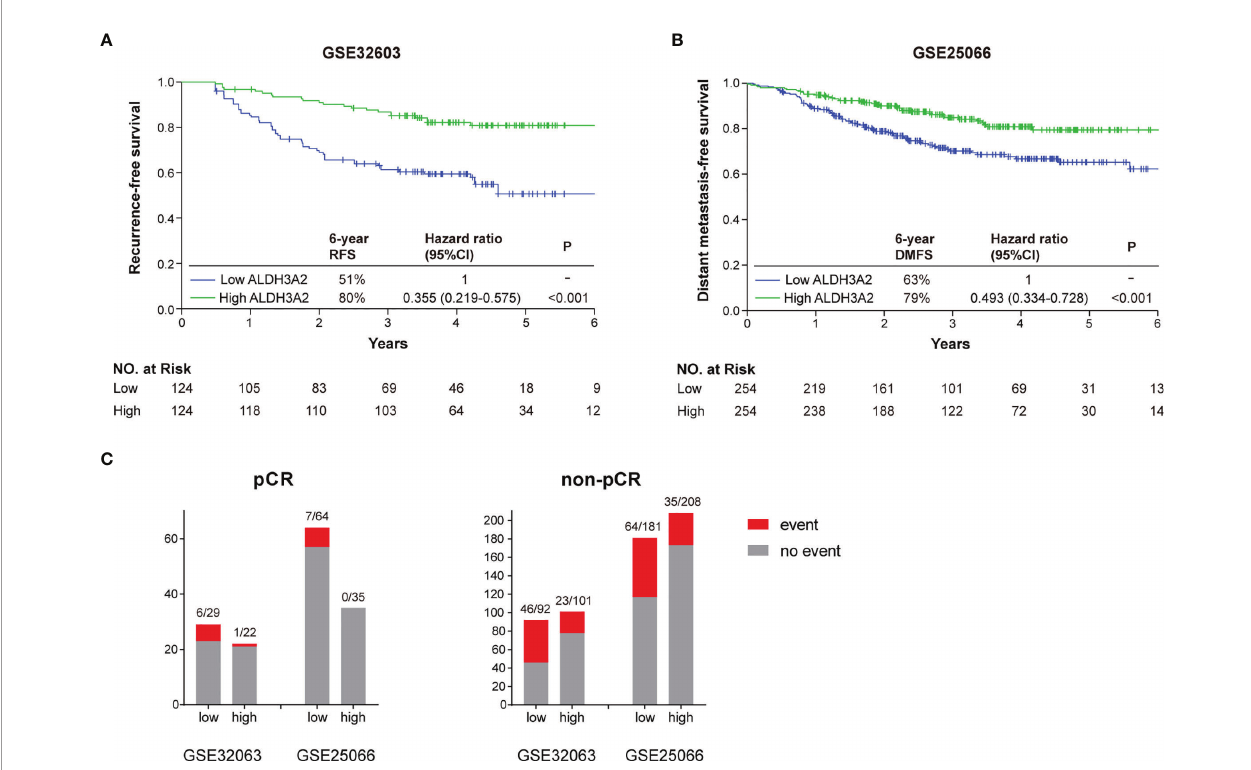
FIGURE 7 | Veri fi cation of ALDH3A2 as a biomarker associated with tumor recurrence in the pCR patients. (A) Kaplan-Meier analysis of recurrence-free survival classi fi ed by the ALDH3A2 tumor expression in GSE32603. (B) Kaplan-Meier analysis of distant metastasis-free survival classi fi ed by the ALDH3A2 tumor expression in GSE25066. (C) Distribution of the recurrent events according to the ALDH3A2 tumor expression in the pCR and non-pCR patients from the GSE32603 and GSE25066 datesets. CI, con fi dence interval; DMFS, distant metastasis-free survival; RFS, recurrence-free